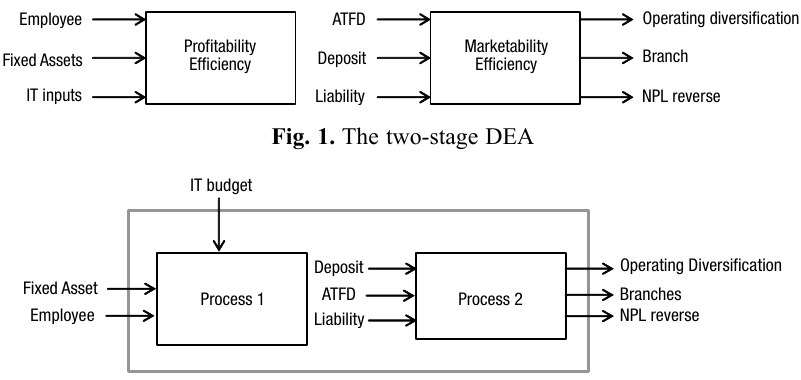
Fig. 2. IT budget with performance in the